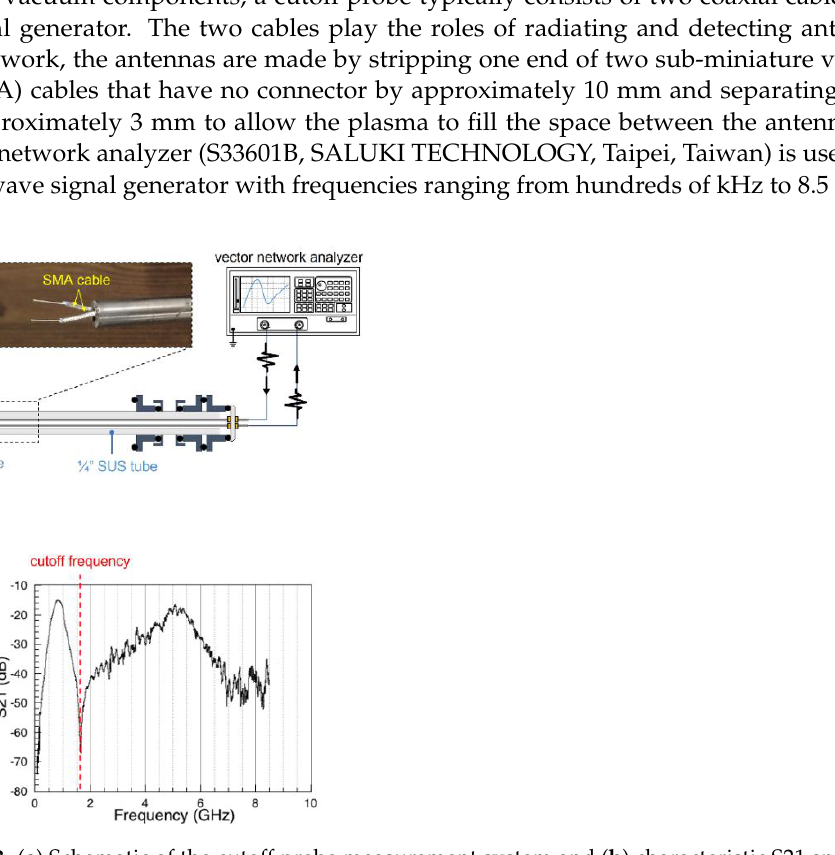
Figure 3. ( a ) Schematic of the cutoff probe measurement system and ( b ) characteristic S21 spectrum of the cutoff probe.